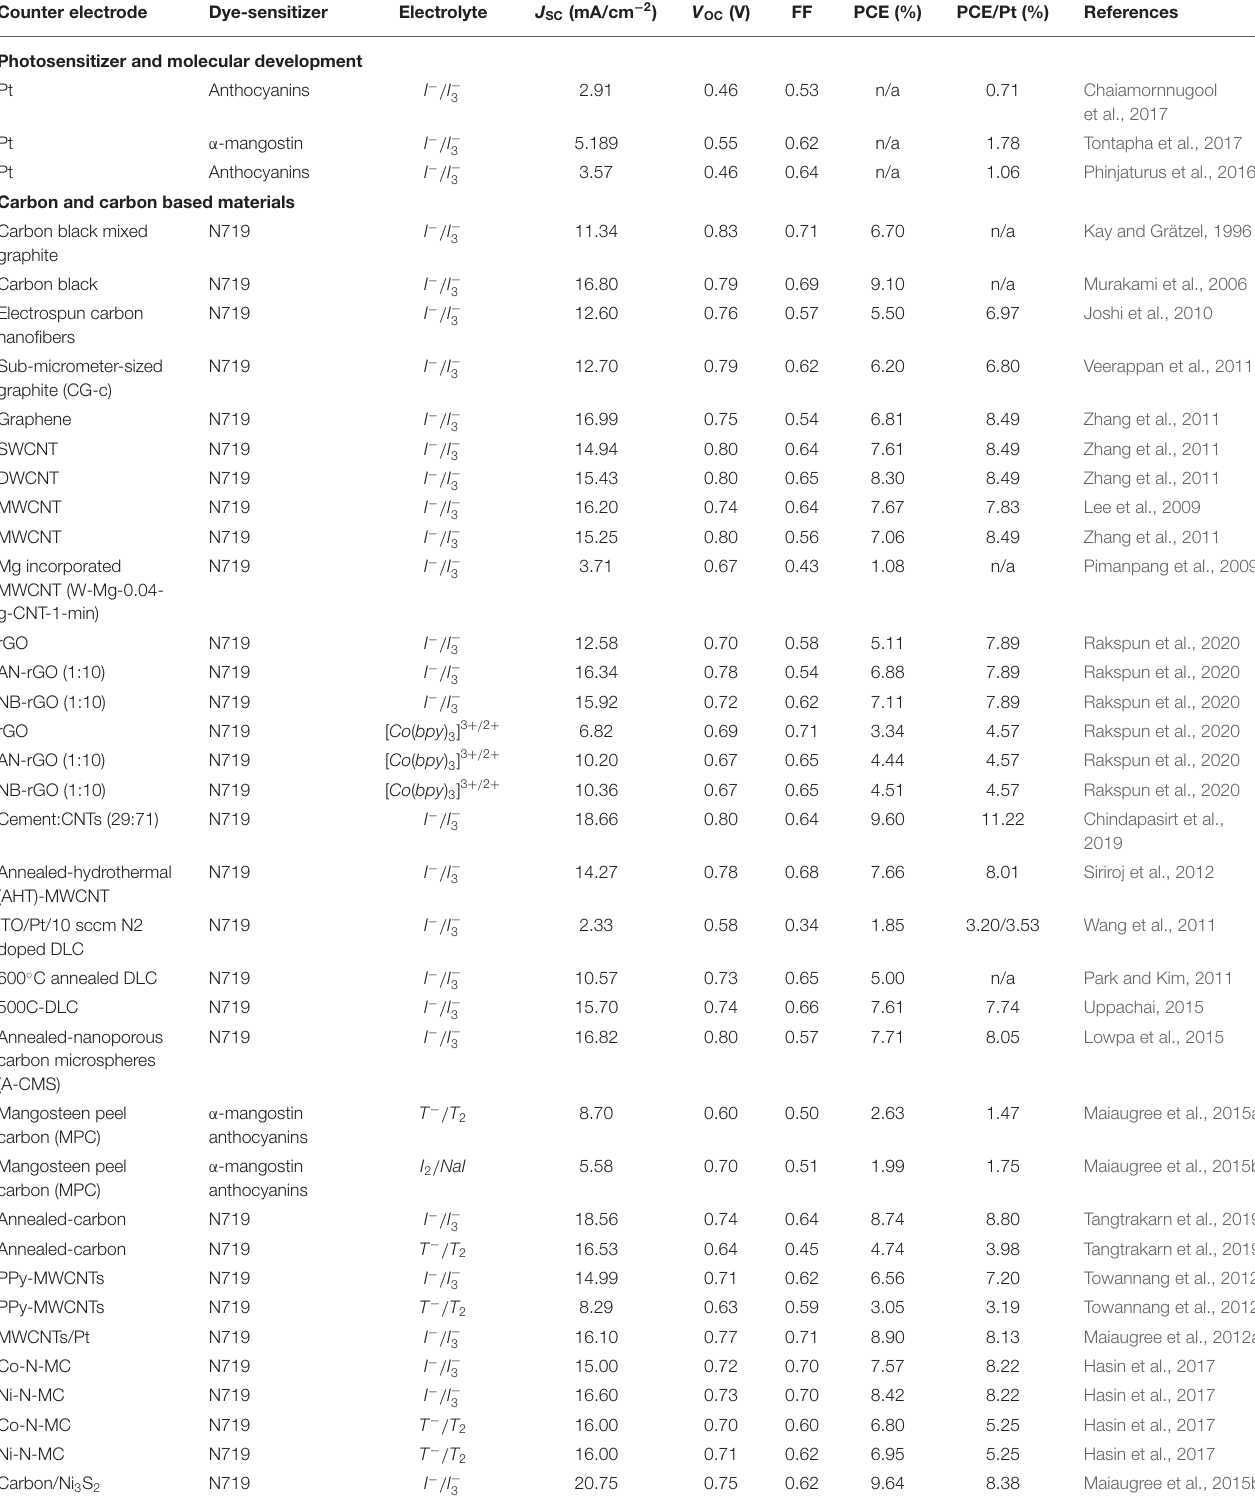
TABLE 1 | Summary of the important results of DSSCs using functional natural sensitizer and carbon, carbon-based, metal-based, and composite-based CE materials. Counter